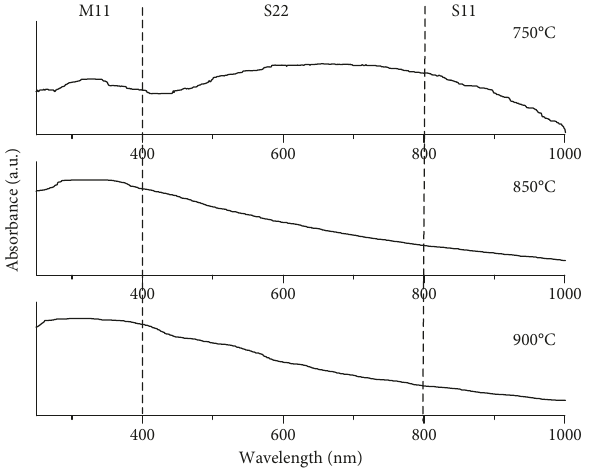
Figure 4: Absorption spectra of 750 ° C, 850 ° C, and 900 ° C, from the visible to near-infrared